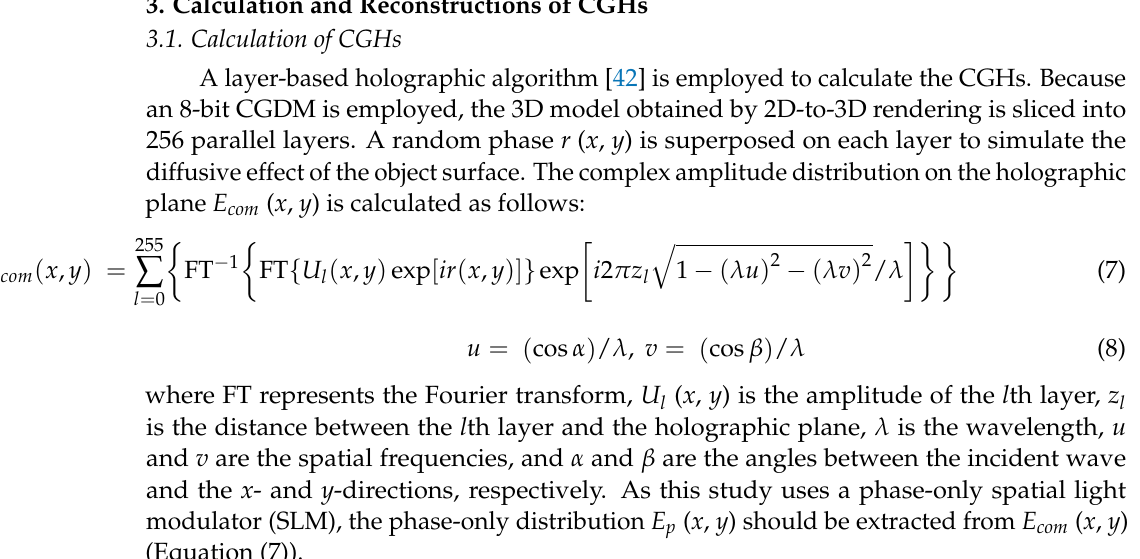
Figure 2. Calculation of the CGDM for a close-up image.